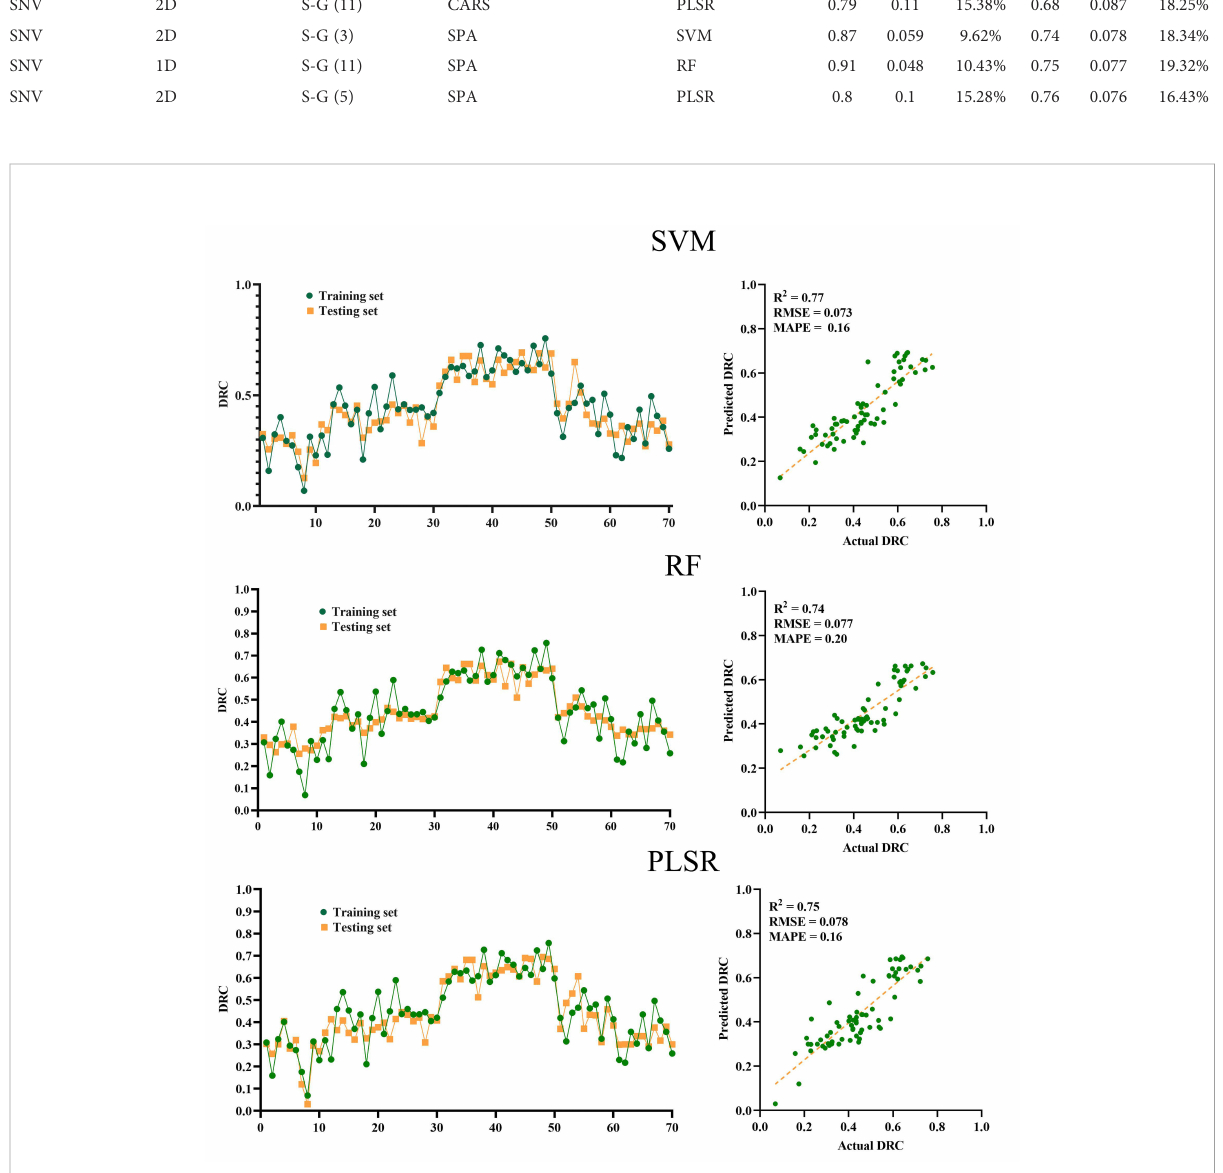
FIGURE 10 Modeling results and regression graphs of the three optimal algorithms (Top down are SVM, RF and